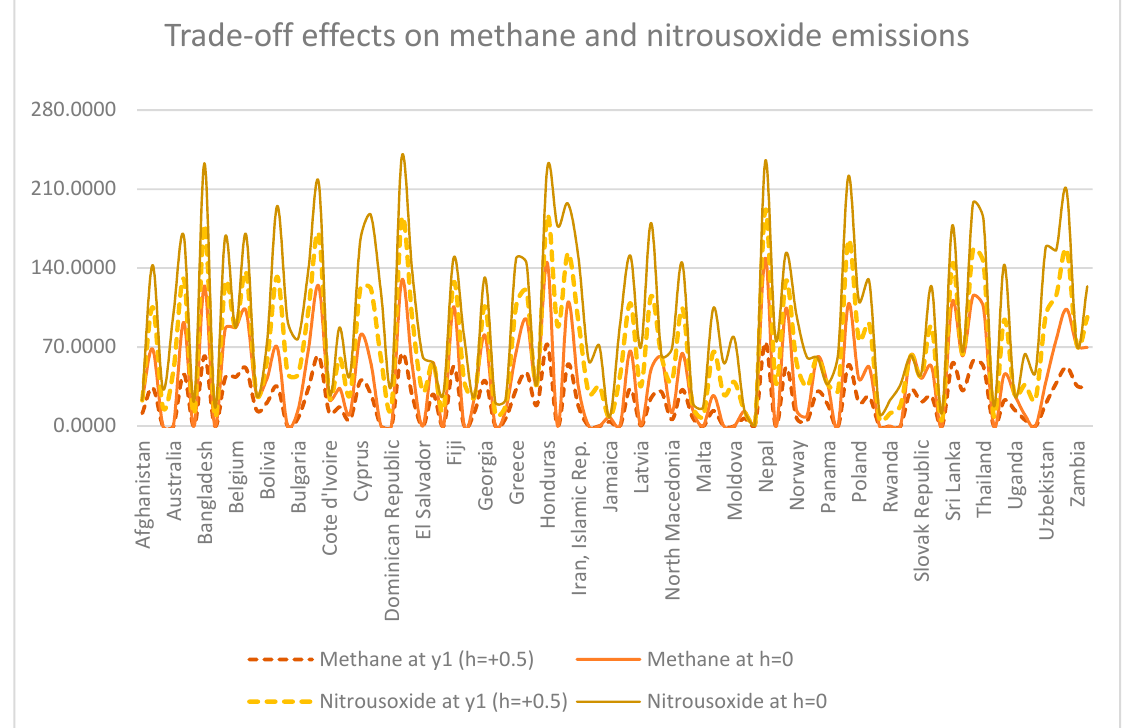
Figure 5. The efficiency change with trade-off ℎ = +0.5 values with desirable outputs ( 𝑦 (cid:2869)(cid:3034)(cid:2878) ).